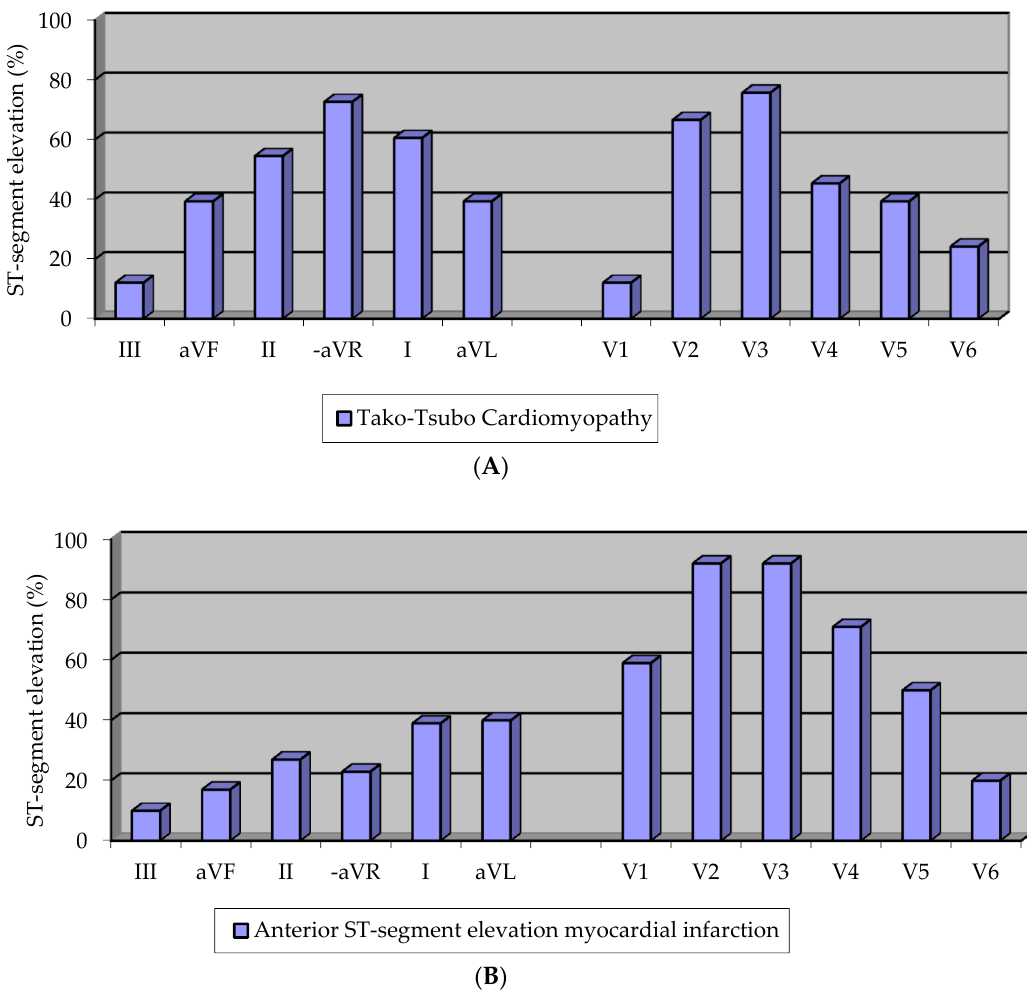
Figure 2. ( A ) Prevalence of ST-segment elevations in TTC; ( B ) prevalence of ST-segment elevations in anterior STEMI. Table 5. Diagnostic accuracy of ECG criteria for differentiation of TTC from STEMI of the anterior wall. Diagnostic Accuracy Prevalence of ST-segment elevation in -aVR (e.g., ST-segment depression in aVR) and absence of ST elevation in